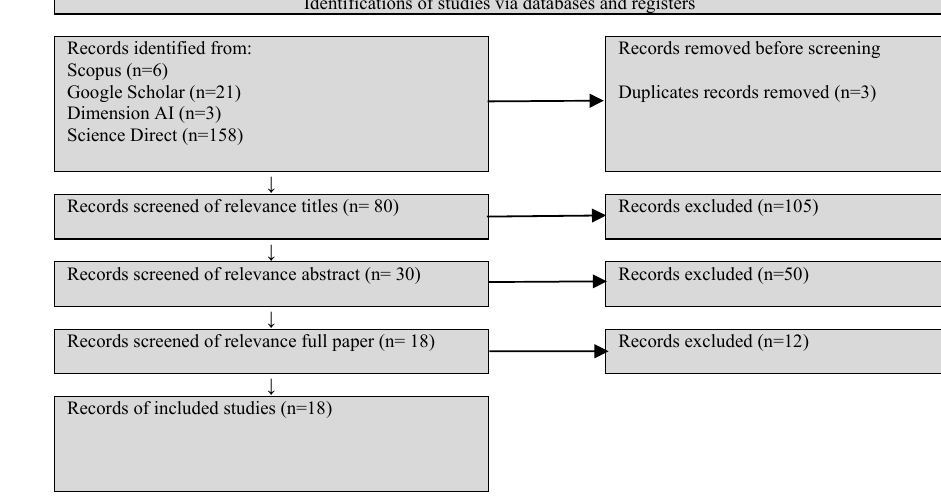
Fig. 1. PRISMA systematic literature review